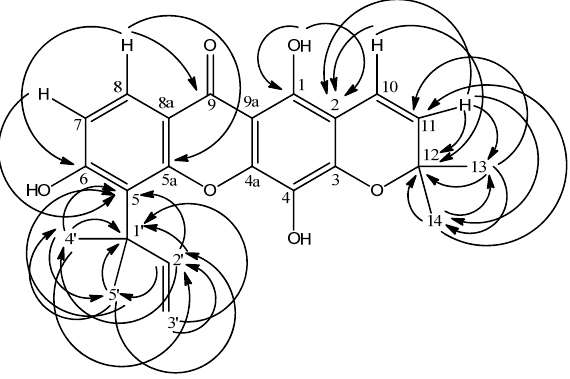
Figure 1. HMBC 2 J and 3 J correlations between 1 H and 13 C in 1